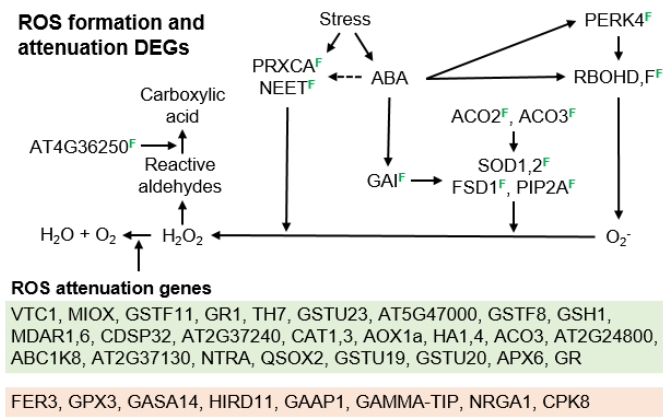
Figure 7. Reactive oxygen species (ROS) formation and attenuation pathways and associated di ff erentially expressed genes (DEGs) as observed between diplosporous Boechera × formosa and sexual Boechera stricta (see Tables S5 and S9). Superscripts identify taxa in which DEGs were upregulated; F, B. × formosa ; S, B. stricta ; red and green highlights indicate up and down-regulation in B. stricta , respectively; arrows indicate upregulation or activation; blunt end lines represent downregulation or suppression.